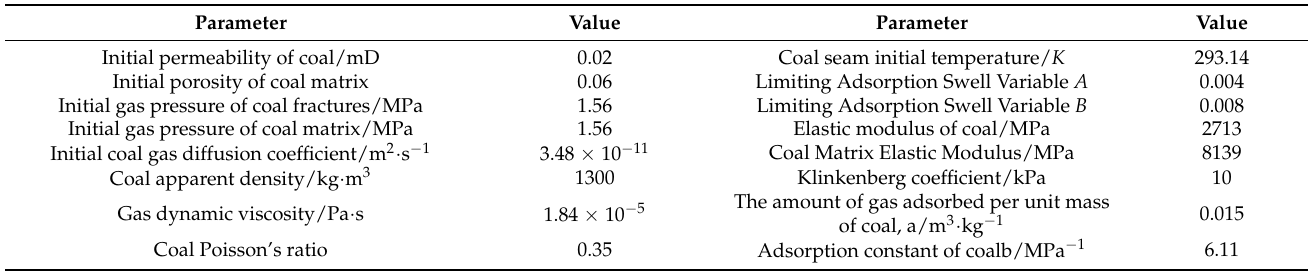
Table 1. Model-related parameter.